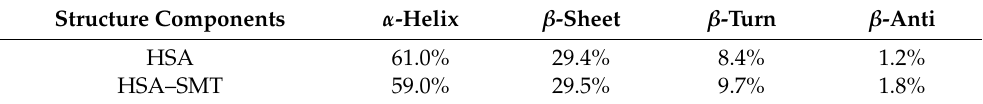
Table 3. Secondary structure contents analysis of HSA and SMT–HSA